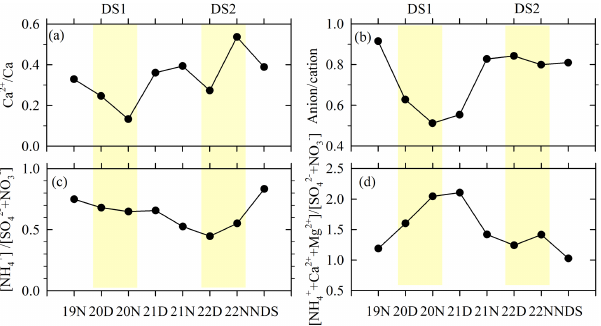
Figure 7. Variations in (a) the ratios of Ca 2 + / Ca, (b) the equiv- alent concentrations of the total anions to the total cations (an- to the sum ion / cation), (c) the equivalent concentrations of NH + 4 + NO − of SO 2 − and NO − ([NH + ] / [SO 2 − ]), and (d) the equiva- 4 3 4 4 3 lent concentrations of the sum of NH + , Ca 2 + , and Mg 2 + to the 4 + Ca 2 + + Mg 2 + ] / [SO 2 − + NO − sum of SO 2 − and NO − ([NH + ]) 4 3 4 4 3 in TSP during 19–22 March and NDS in